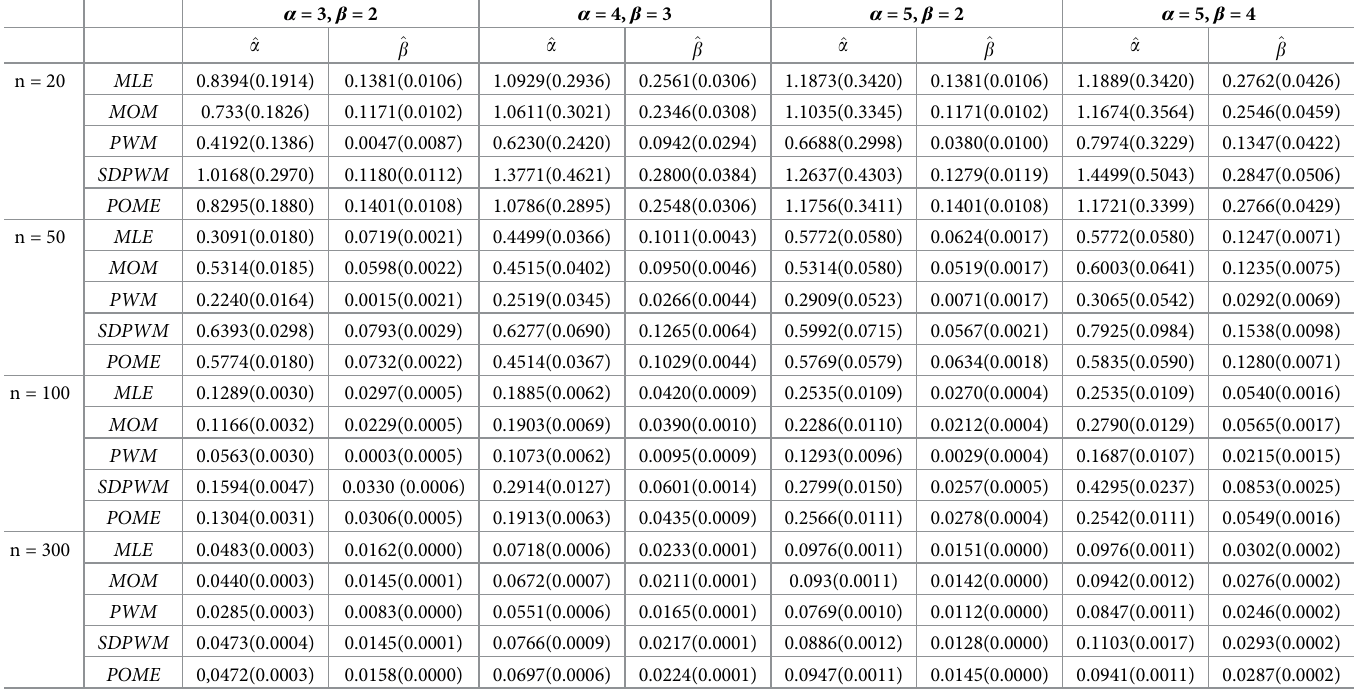
Table 7. Bias and MSE (parentheses) for the estimators of α and β when α > β and for different choices of n